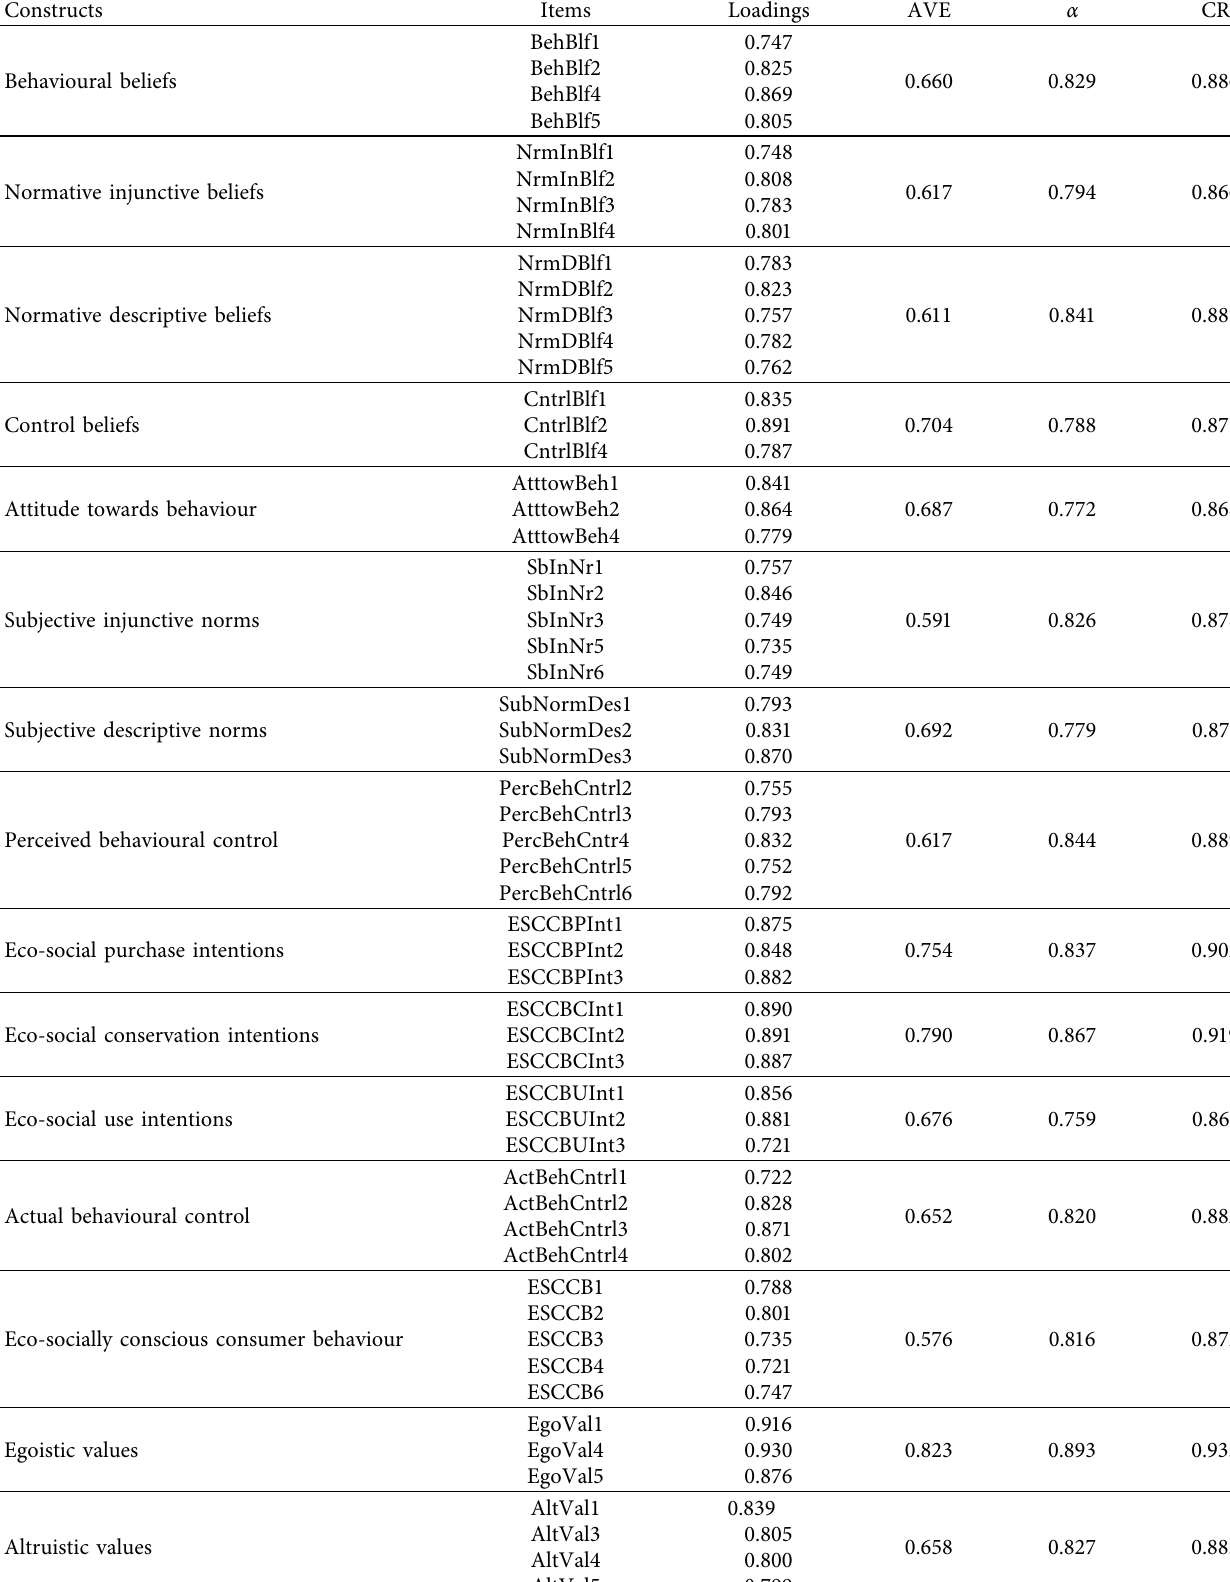
Table 3: Standardized loadings, composite reliability, and AVEs of